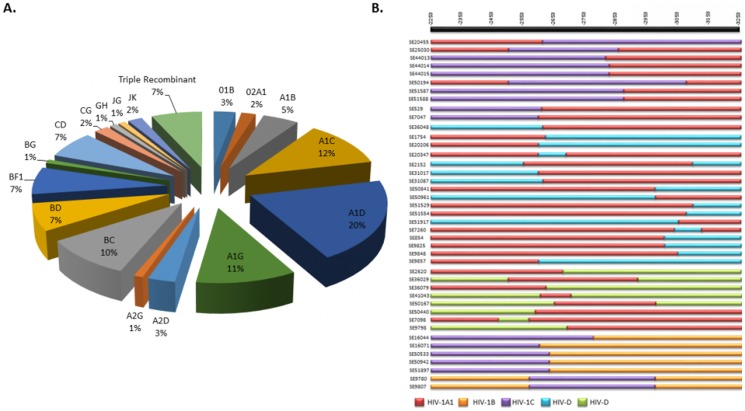
Types and mosaic pattern of HIV-1 unique recombinant forms identified in Sweden.
A. Proportion of recombinant forms was identified based on REGAv3, COMET and RIP 3.0 followed by bootscan analysis incorporated in REGAv3 and SimPlot analysis. B. Mosaic pattern of URFs identified by REGAv3 and SimPlot. Major URFs (A1C, A1D, BC, A1G) which have HXB2 positions 2253 to 3260 and had minimum degenerate bases (≤5) were used for bootscan analysis (n = 43) implemented in Rega v3 with 400 bp window size and 20 bp step size and SimPlot analysis with 300 bp window size and 20 bp step size. The reference sequences were selected for SimPlot analysis is based on the recombinant pattern. Upper bar presents HXB2 co-ordinate.